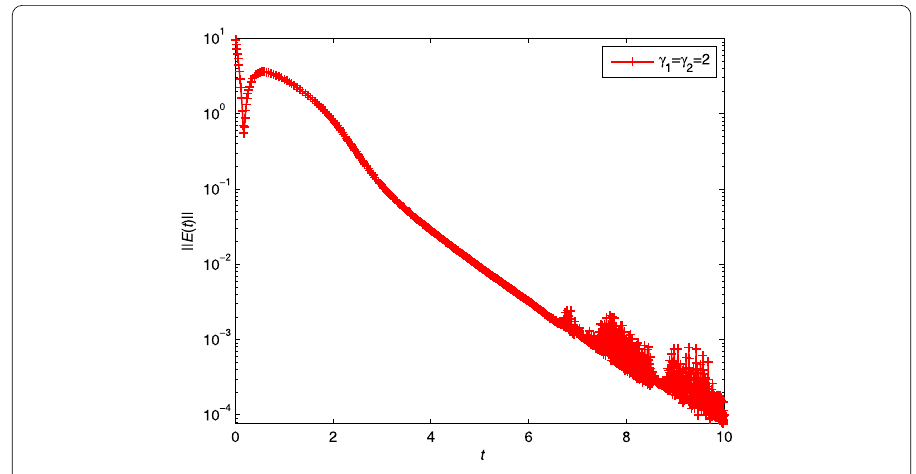
Figure 5 The trajectory of the residual error (cid:9) E ( t ) (cid:9) synthesized by NTCTZNN3